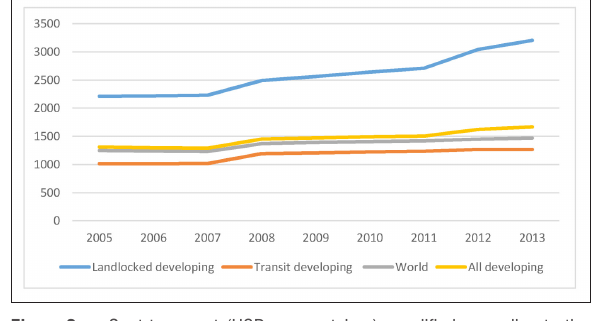
Average number of days (TT) and costs (TC, USD per TEU) to export by year, 2008–2013 (modified based on UN-OHRLLS 11 indicators)